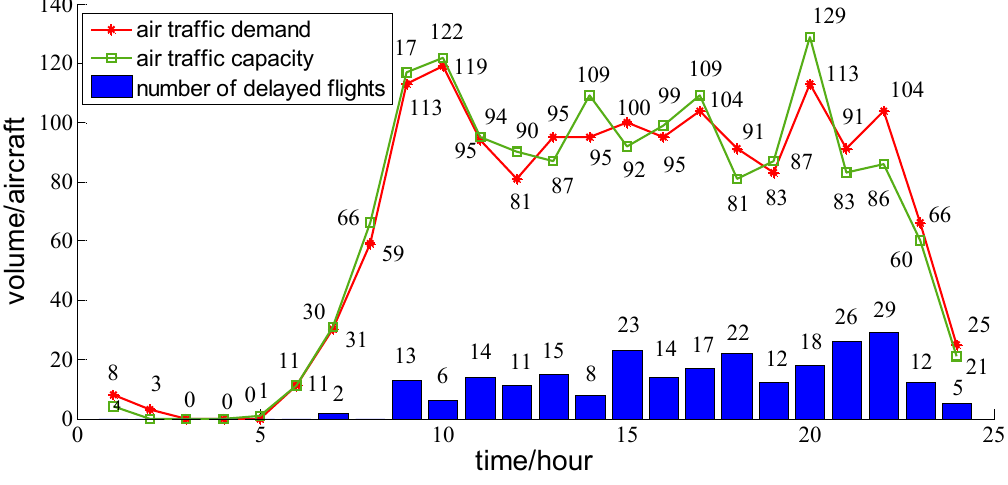
Figure 5. Flight schedule on 15 January of ATL airport.